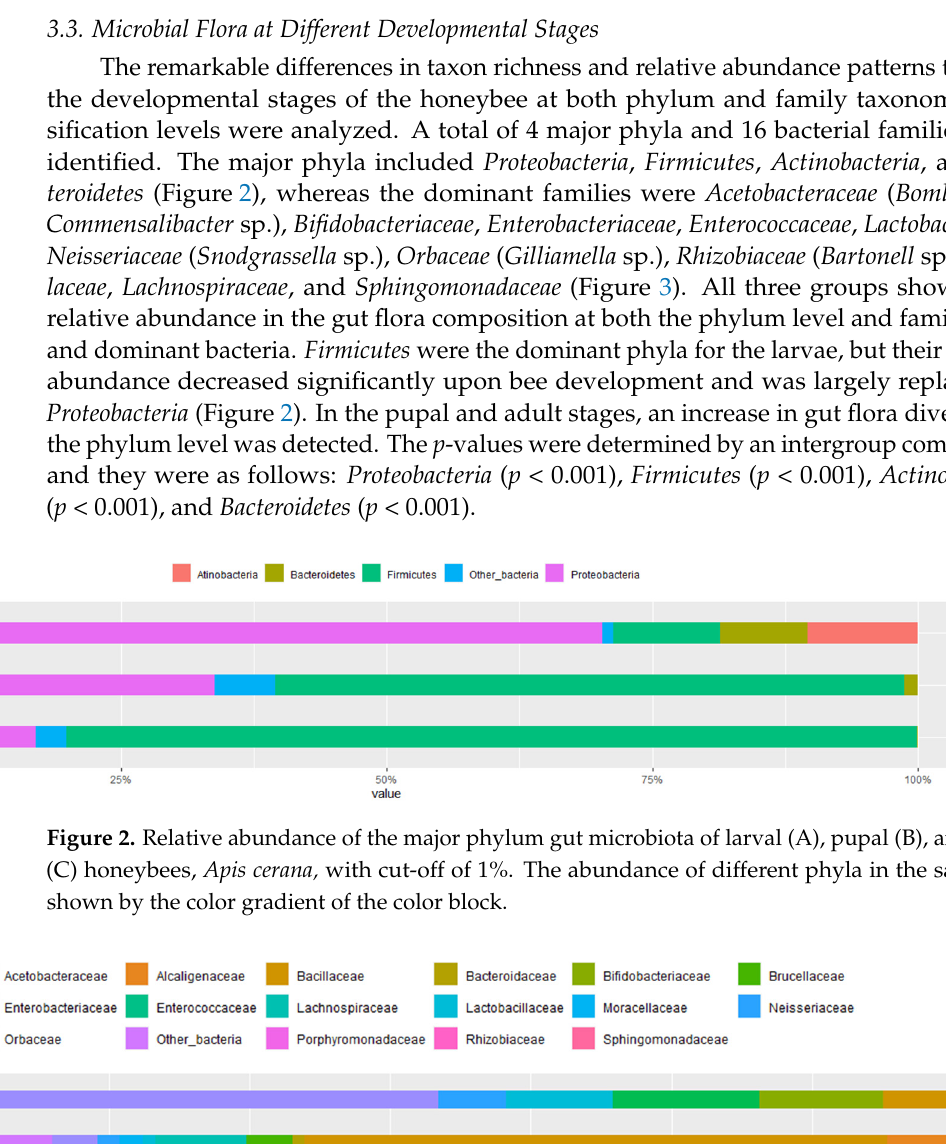
Figure 3. Relative abundance of the major families of gut microbiota of larval (A), pupal (B), and adult (C) honeybees, Apis cerana, with cut-off of 1%. The abundance of different families in the sample is shown by the color gradient of the color block.